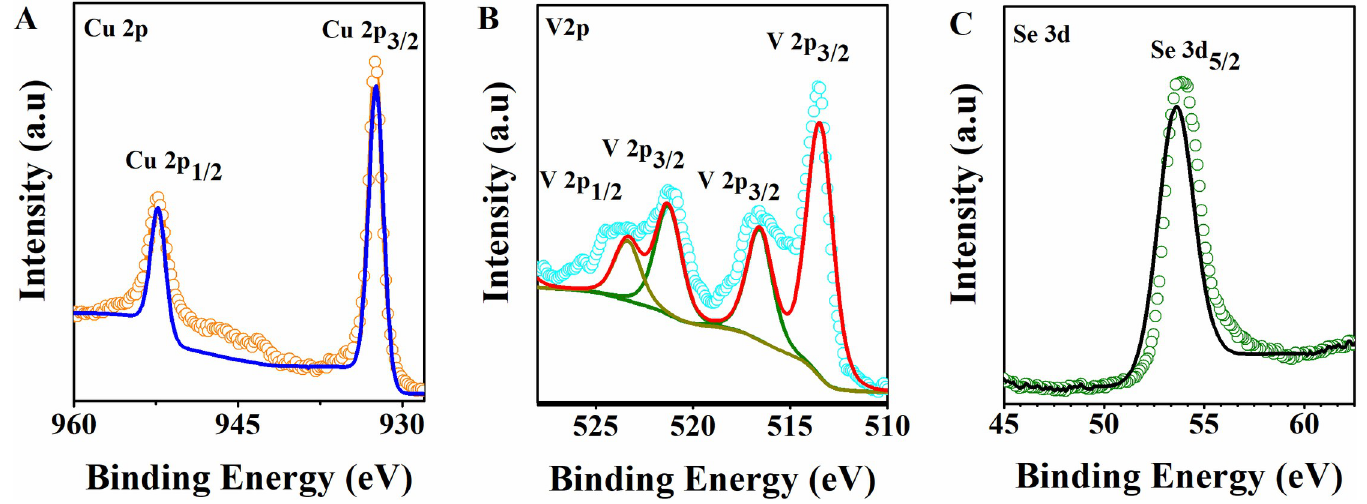
Fig 3. XPS spectra of the Cu 2p, V 2p and Se 3d peaks of CVSe NCs.